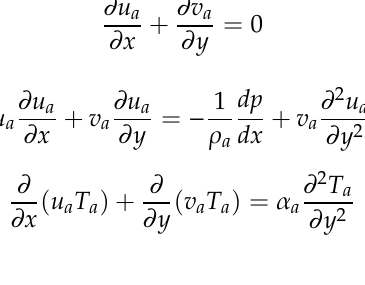
Figure 2. Description of the calculation element of the pre-cooling IEC.